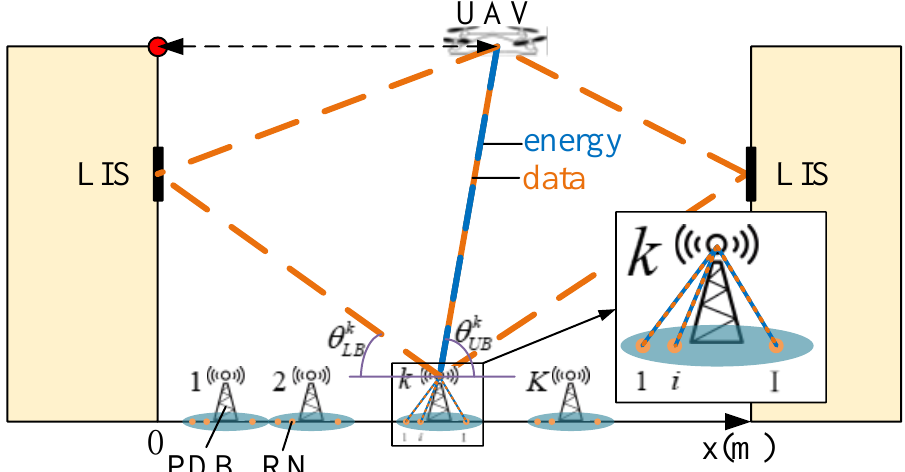
Figure 1. The scene with unmanned aerial vehicles (UAVs), the internet of things (IOT), and large intelligent surfaces